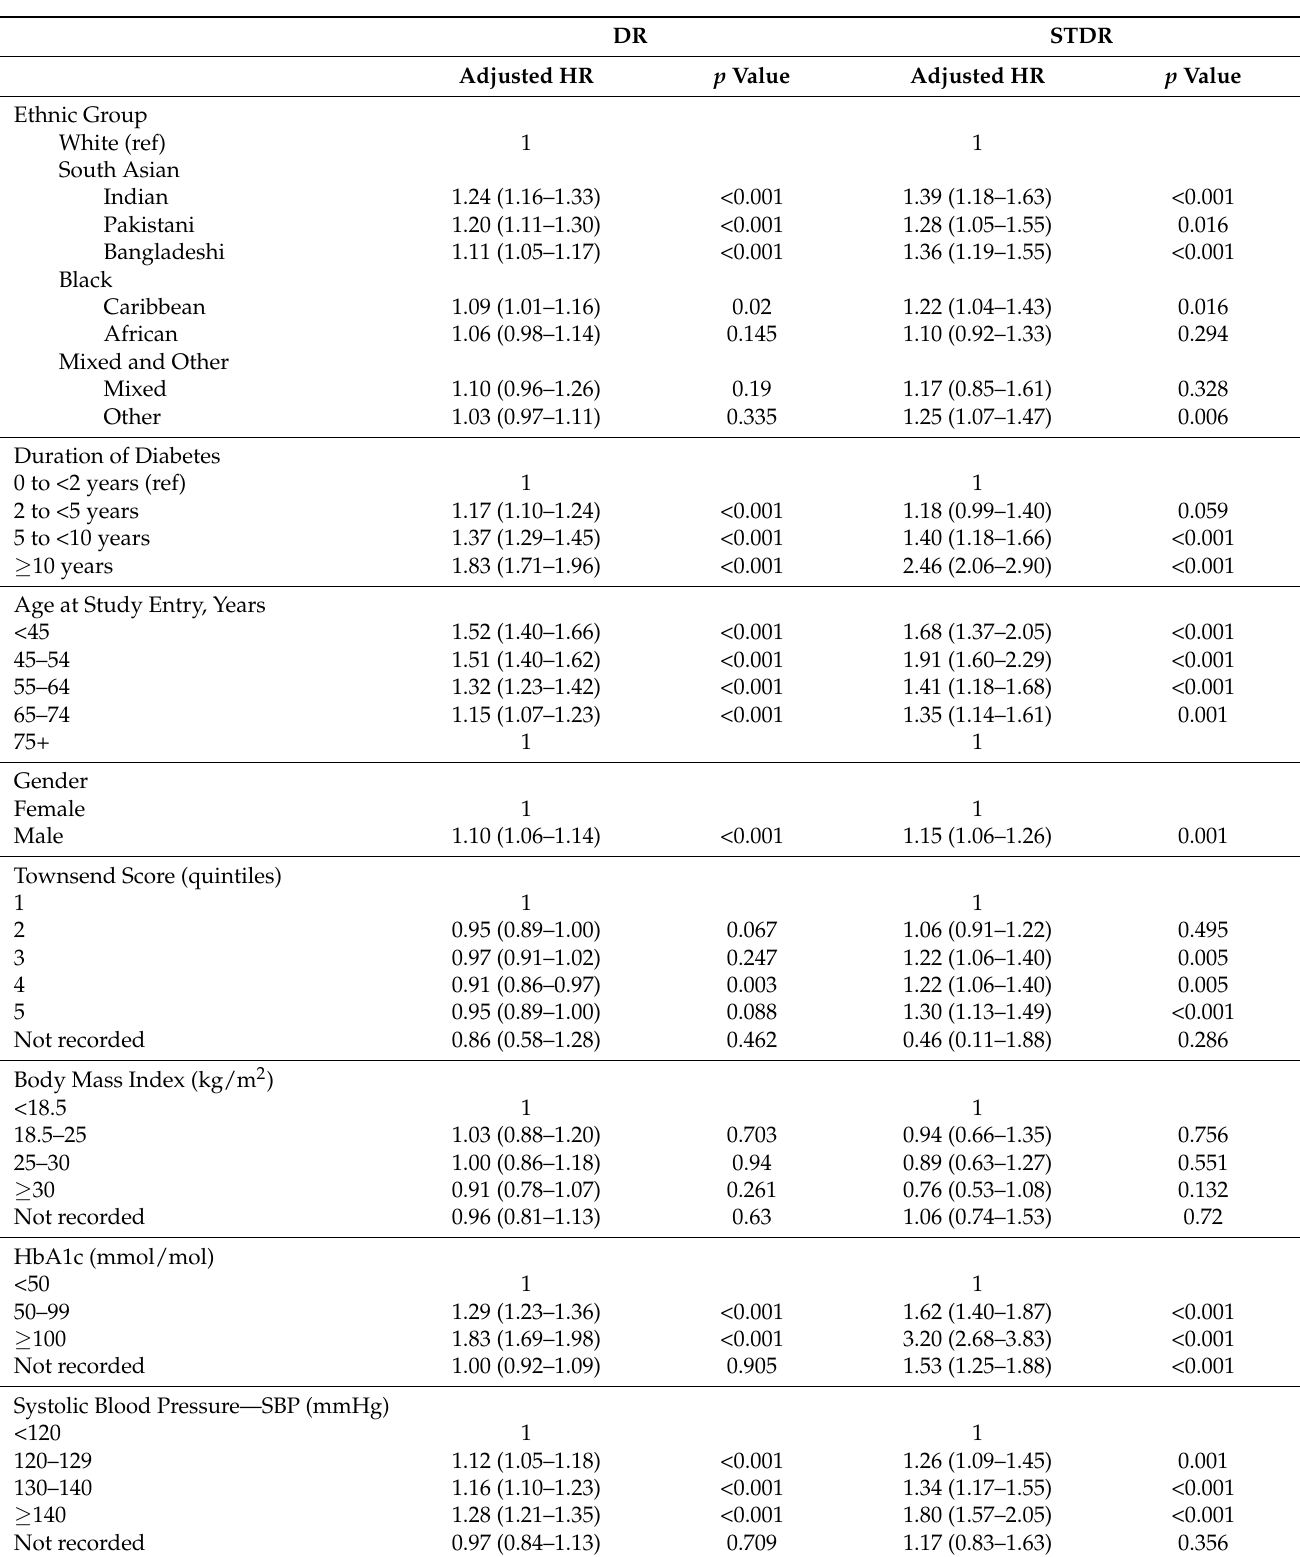
Table 5. Multivariable Cox regression analysis of outcome measures in people with known diabetes—KnownT2DM